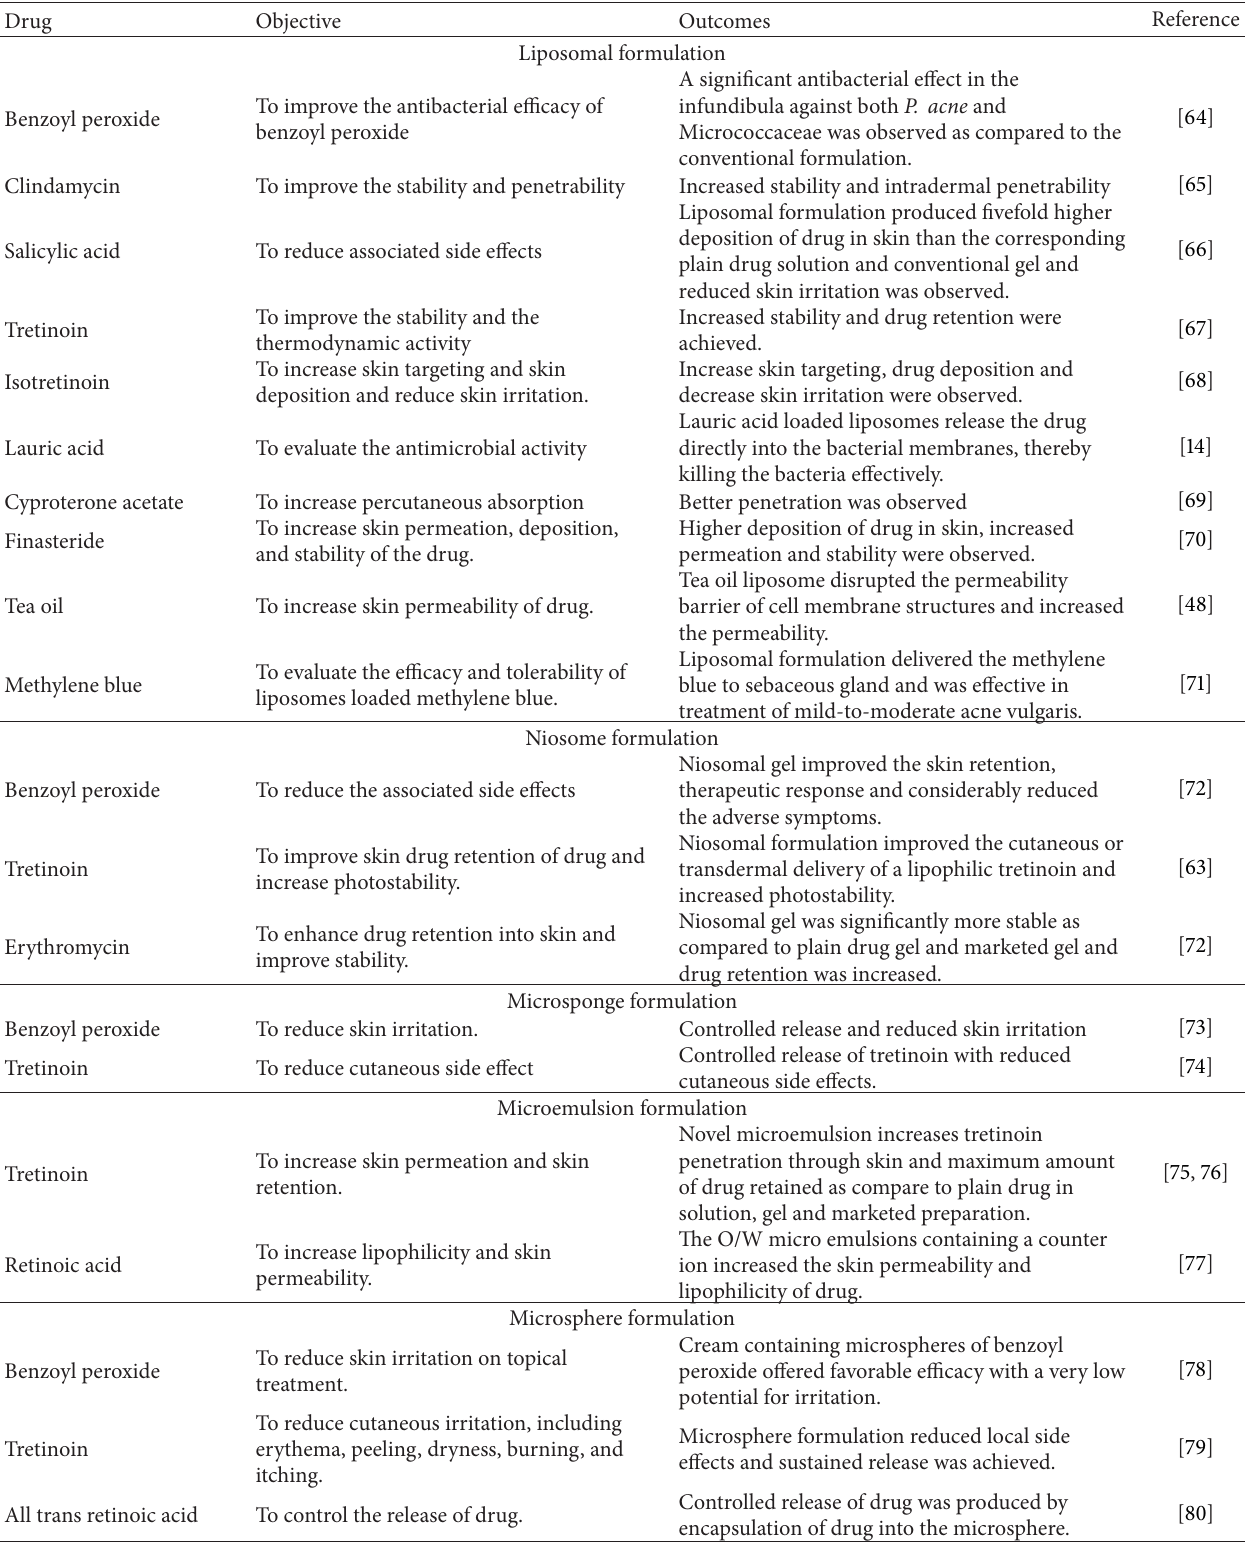
Table 5: Novel carrier-based delivery system for